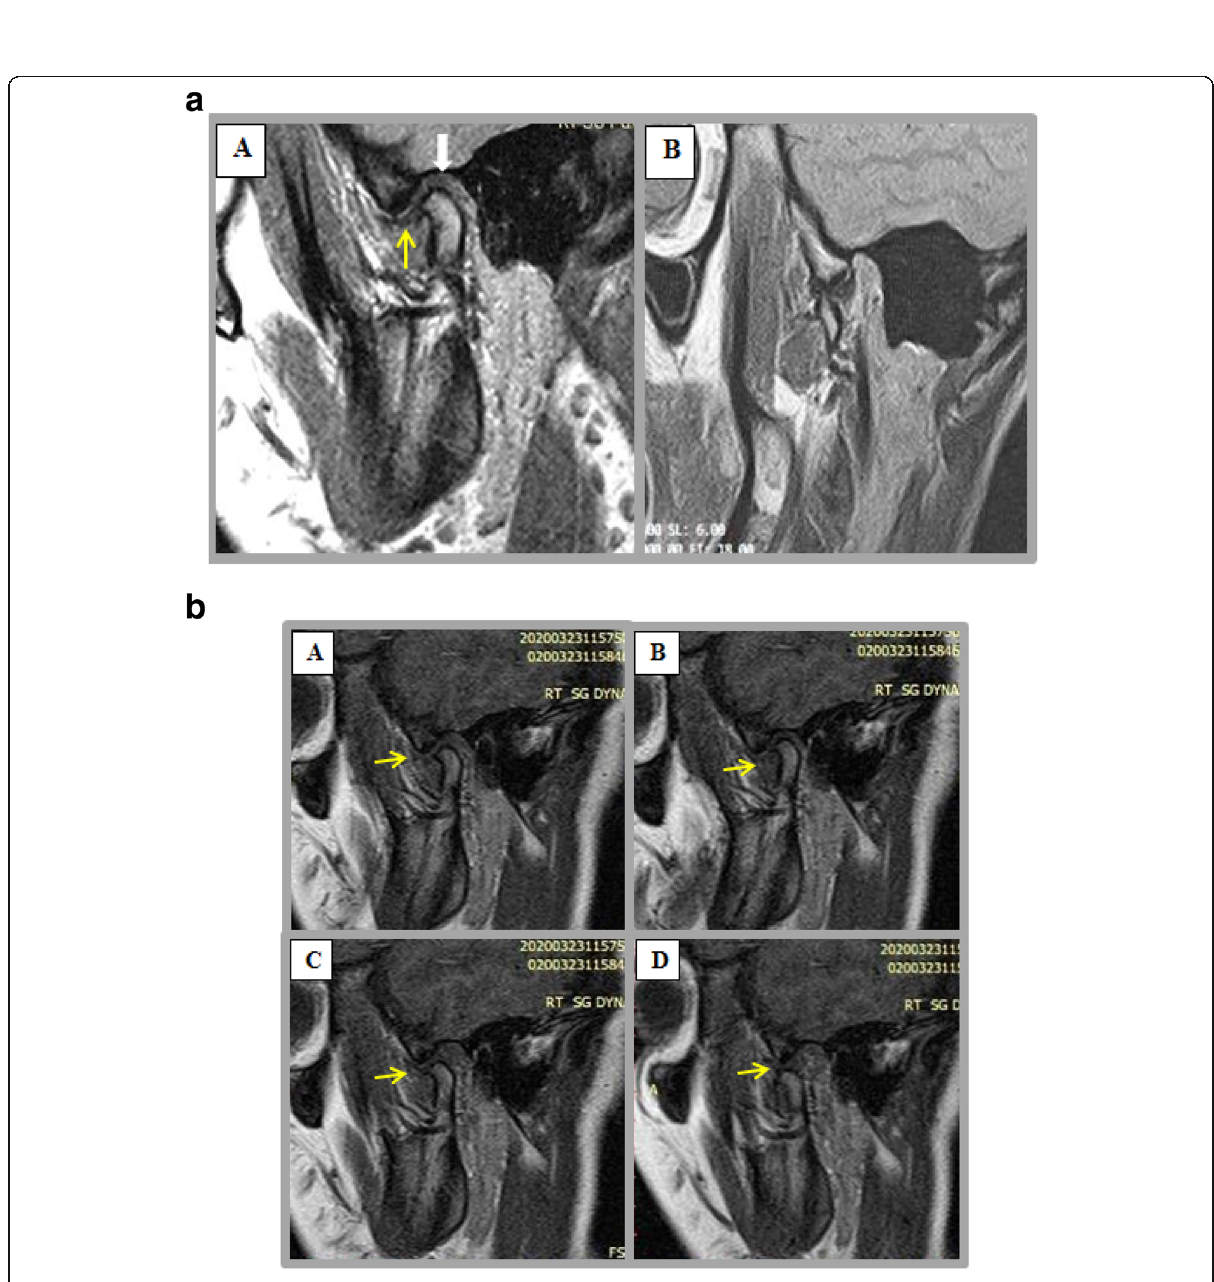
Fig. 3 a (A, B) A 21-year-old female patient, presented clinically by temporomandibular joint pain and clicking on the right side. Sagittal PDWI MRI of right TMJ in closed (A) and open (B) mouth position revealed anterior disc displacement with reduction: posterior band of articular disc (yellow arrow) is seen anterior to the condyle in closed mouth view with normal position in open view. Thickening of superior layer of retrodiscal tissue was noted giving pseudodisc sign (white arrow). b (A – D) Dynamic MRI study of right TMJ revealed anteriorly displaced disc in relation to condylar head with reduction on opening of the mouth associated with normal condylar